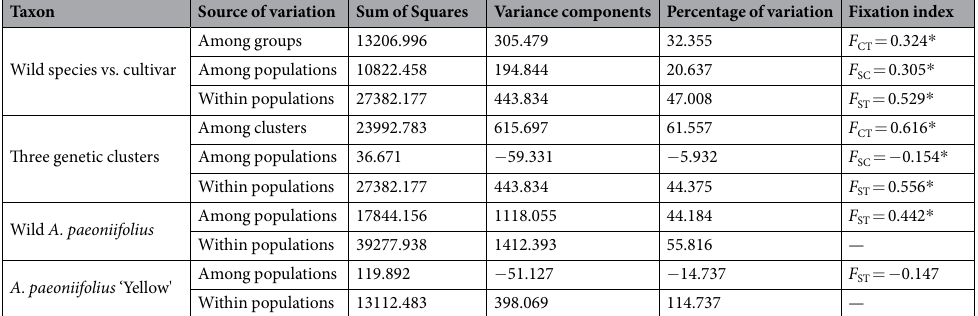
Table 2. Results of the analyses of molecular variance (AMOVA). Percentage of total genetic variation is given and the corresponding fixation indices are given. ( * P < 0.01).